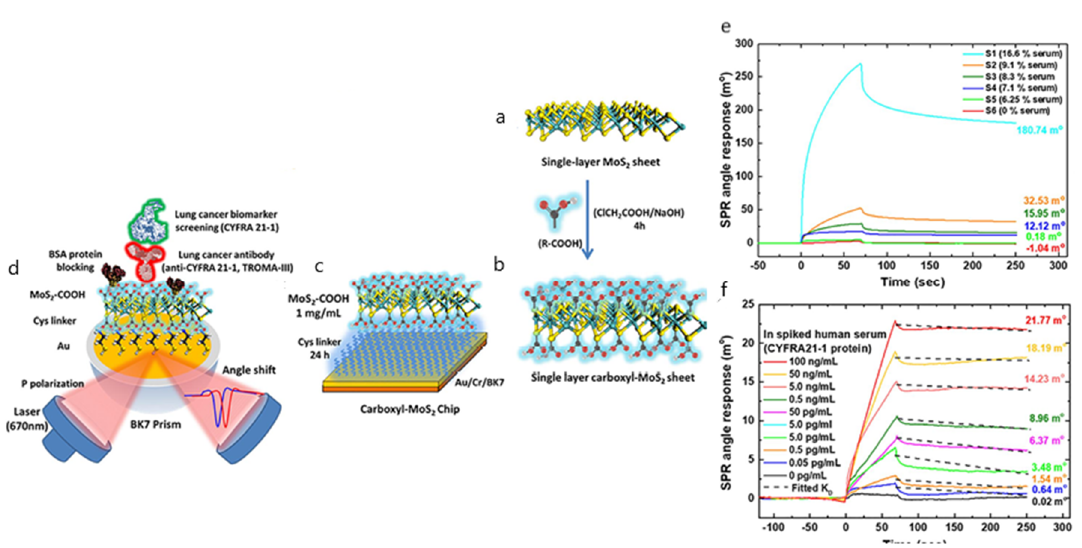
Figure 7. ( a ) Scheme of the synthesis route of single-layer MoS 2 ; ( b ) single-layer carboxyl-MoS 2 nanocomposites; ( c ) the carboxyl-MoS 2 -based SPR chip; ( d ) the carboxyl-MoS 2 -based SPR sensing mechanism to detect the lung cancer biomarker CYFRA21-1. SPR sensorgrams were analyzed for the CYFRA21-1 protein in spiked human serum samples using the carboxyl-MoS 2 -based chip, showing ( e ) different serum concentrations that were used to assess interference analysis during the test and ( f ) comparisons of different serum ratios in SPR biosensing for interference analysis. Adapted with permission from Chiu et al. [78] (under the terms and conditions of the Creative Commons